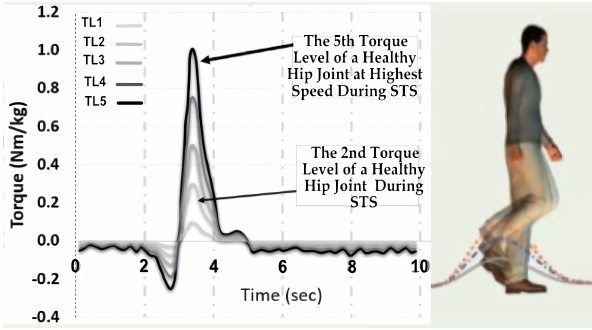
Figure 1. The hip torque during STS activity [8,44].